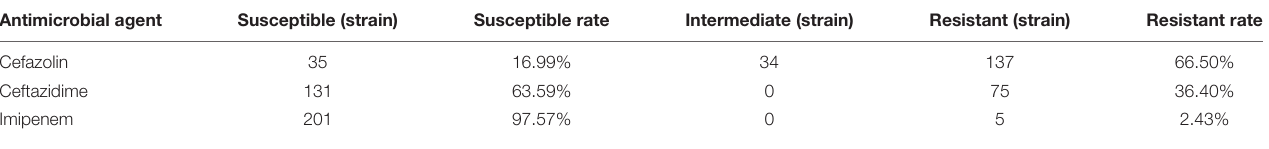
TABLE 1 | Resistant phenotype of 206 E. coli from livestock and poultry. Antimicrobial